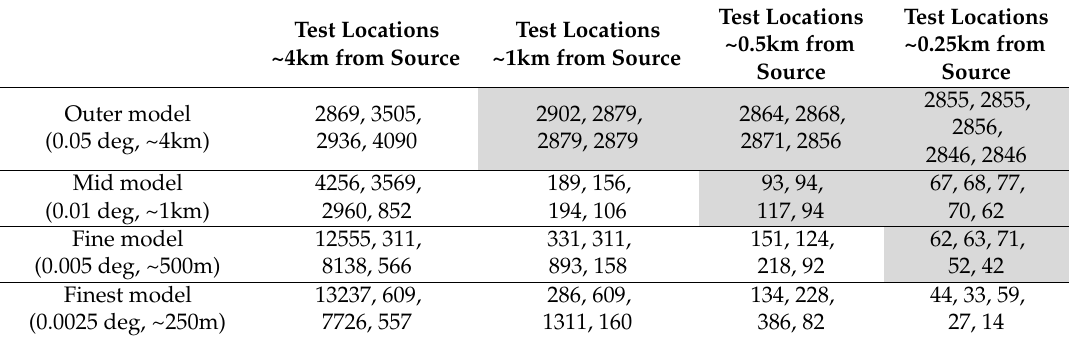
Table 2. Harmonic mean dilutions, computed at locations at varying distances from the source, indicated in Figure 11b. Values in grey shading indicate spatially interpolated harmonic mean dilution